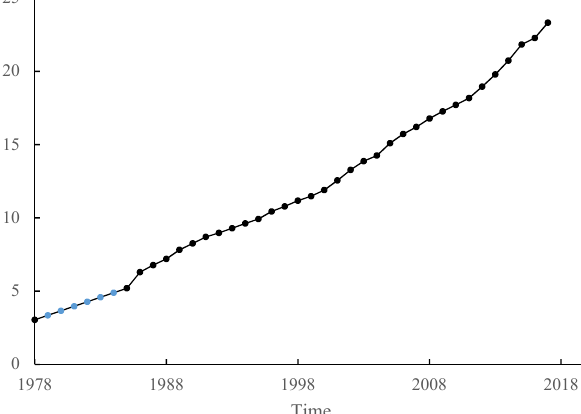
Figure 2. Proportions of impervious surfaces in Jinan City (the blue dots represent interpolation data during the period of 1979-1984).